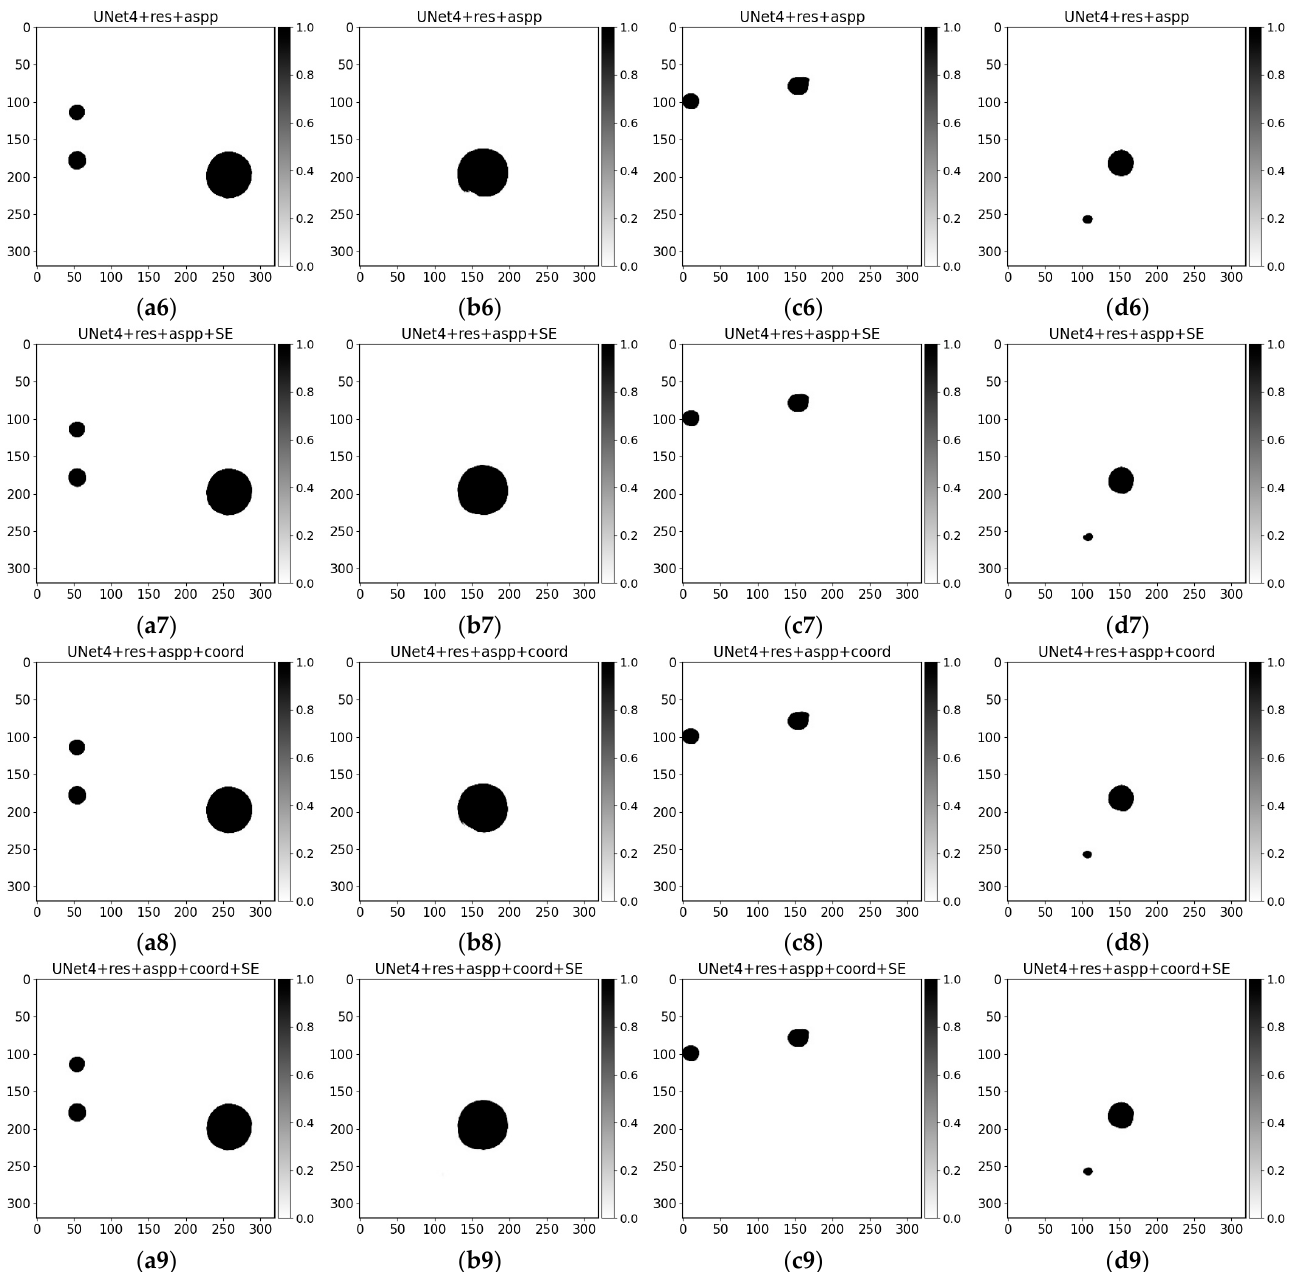
Figure 13. Each neural network architecture output on 4 cropped samples from the test set. Images ( a0 – d0 ), labels ( a1 – d1 ), network predictions ( a2 – d9 ) .